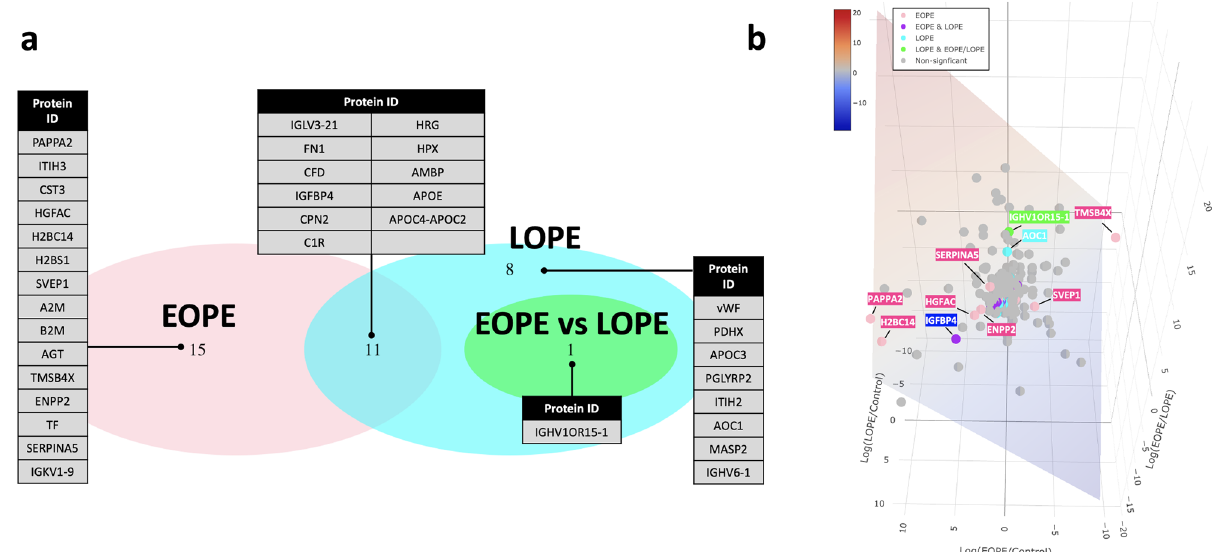
Figure 2. Highlighted proteins in differential expression analysis. ( a ) Triple Venn diagram summarising the differentially expressed proteins unique and overlapped between EOPE versus healthy pregnancy, LOPE versus healthy pregnancy and EOPE versus LOPE. ( b ) Three-dimensional plot of fold changes (log 2 -transformed) of all identified proteins, with regression plane filled with colour indicator of log 2 -fold changes. Source data are provided as a Source Data